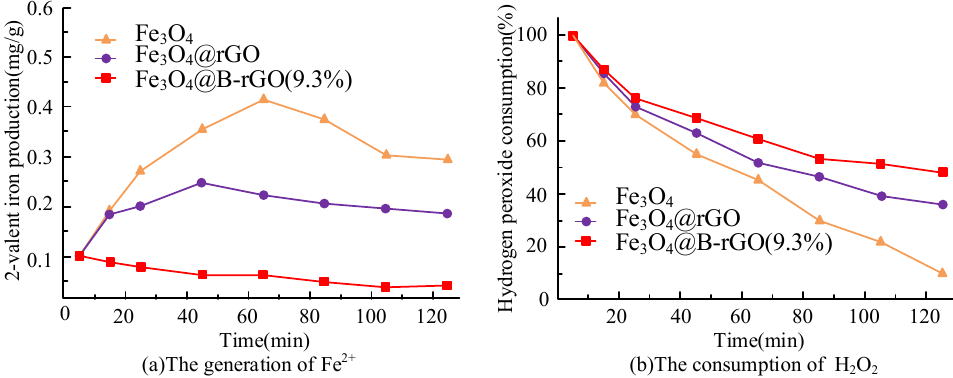
Figure 10. The generation of Fe 2+ ( a ) and the consumption of hydrogen peroxide ( b ) during pho- to-Fenton.